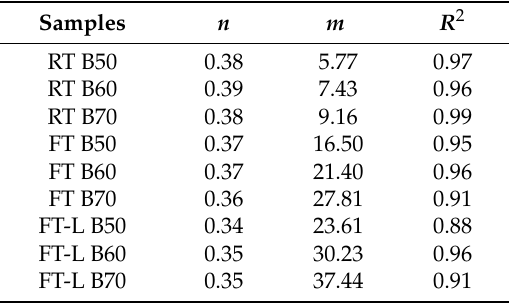
Table 3. Average values of material constant n , creep parameter m , and correlation coe ffi cient R 2 .